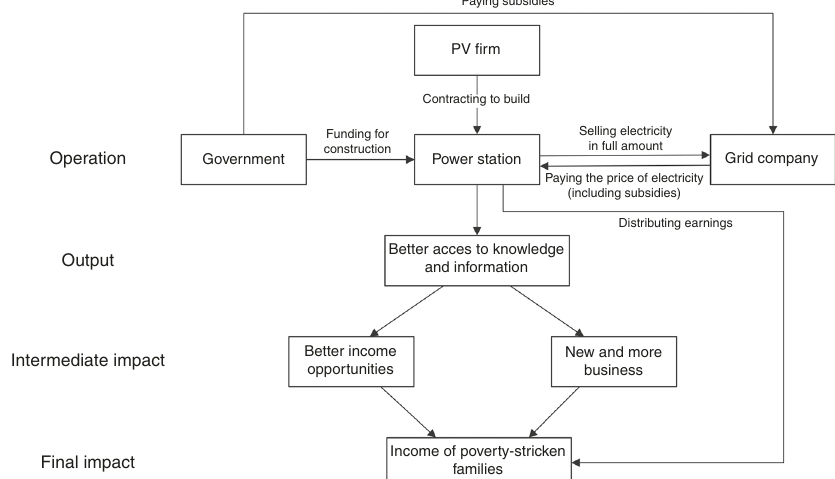
Fig. 3 Channels through which household income is affected by the SEPAP. Source: Our own adaptation from Bridge et al. 33 , Diallo and Moussa 37 , Lenz et al. 38 , and Peters and Sievert 39 . The SEPAP program stipulates that the non-residential PV stations funded by governments shall be owned by village collectives. The electricity generated by the power stations is sold to the state grid company after being connected to the grid. The power price sold consists of two parts: desulfurization price and government subsidy. The village collectives shall determine the income distribution mode of the project. Most of the income generated by these projects is directly distributed to eligible poverty-stricken families. The SEPAP also entitles poverty-stricken families to the better access to knowledge and information, and this is an indirect channel affecting income of poverty-stricken